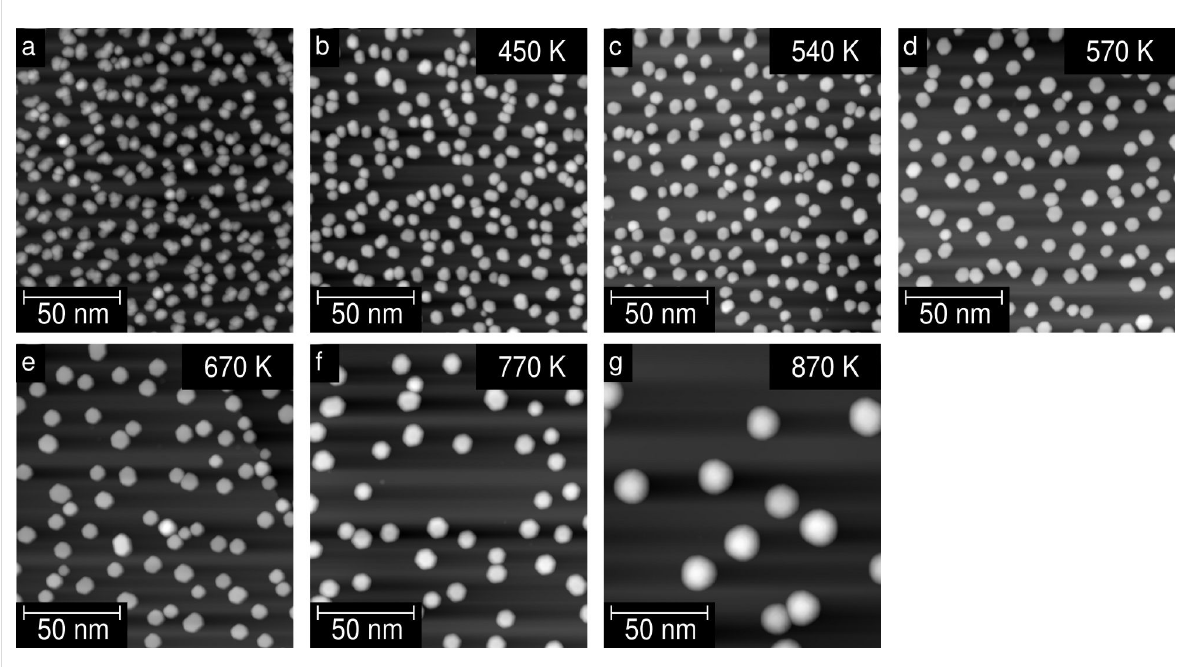
Figure 4: Temperature dependence of the annealing behaviour of the Ni clusters. STM topographic images of the HOPG sample (a) after deposition of Ni on the cold sample and (b–g) after the different annealing steps. Annealing was performed stepwise, starting at T ≈ 450 K (b) up to T ≈ 870 K (g). All data were obtained at V = 1.0 V with a tunnelling current of I = 0.2 nA in consistency with Figure 1.